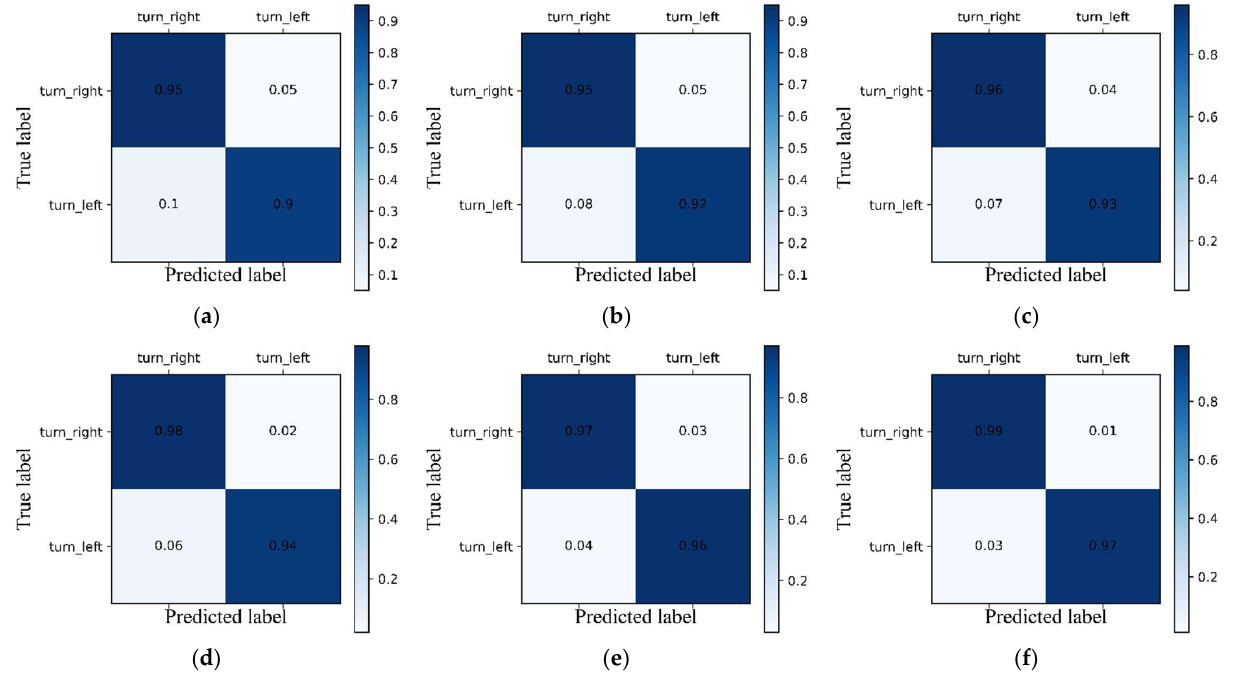
Figure 17. Confusion matrix. ( a ) XGBoost_moment, ( b ) LightGBM_moment, ( c ) Stacking fusion model_moment, ( d ) XGBoost_history, ( e ) LightGBM_history, ( f ) Stacking fusion model_history.